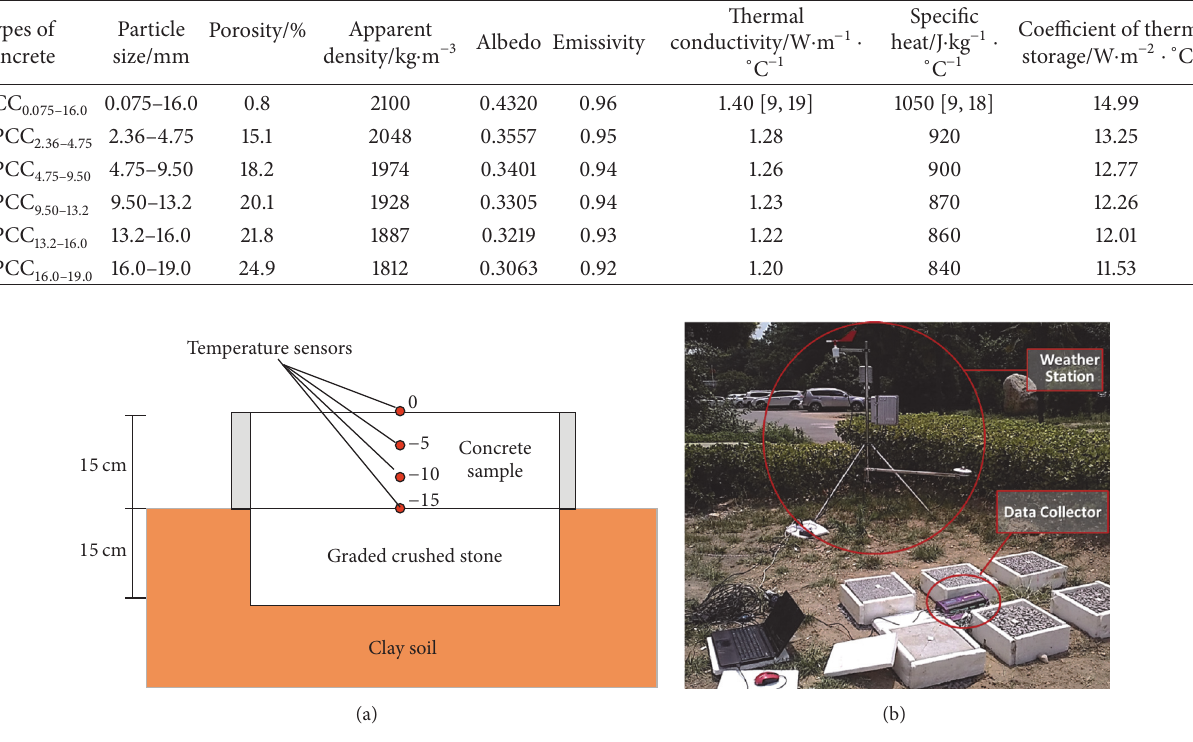
Figure 1: Temperature monitoring system: (a) schematic figure of slabs specimens; (b) photograph of the experimental